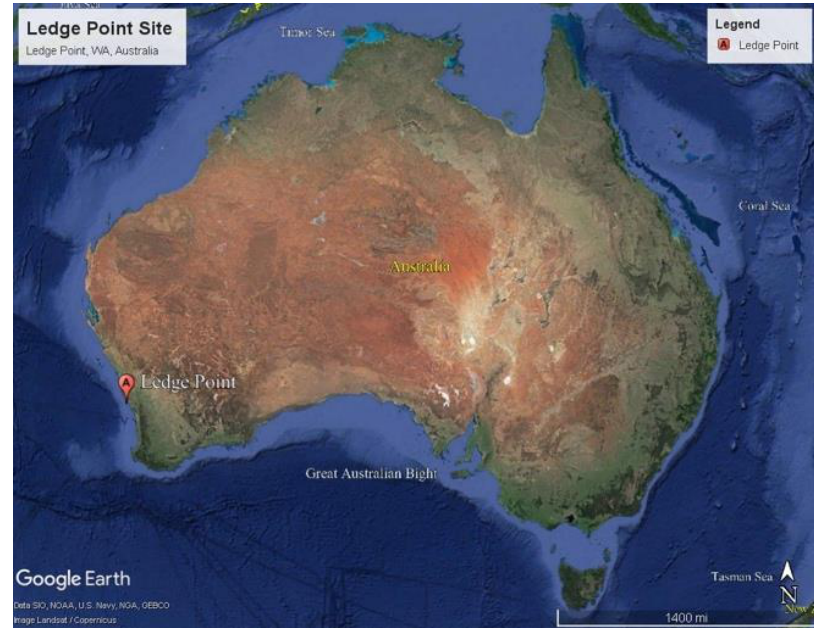
Figure 1. Ledge Point calcareous sand site location.